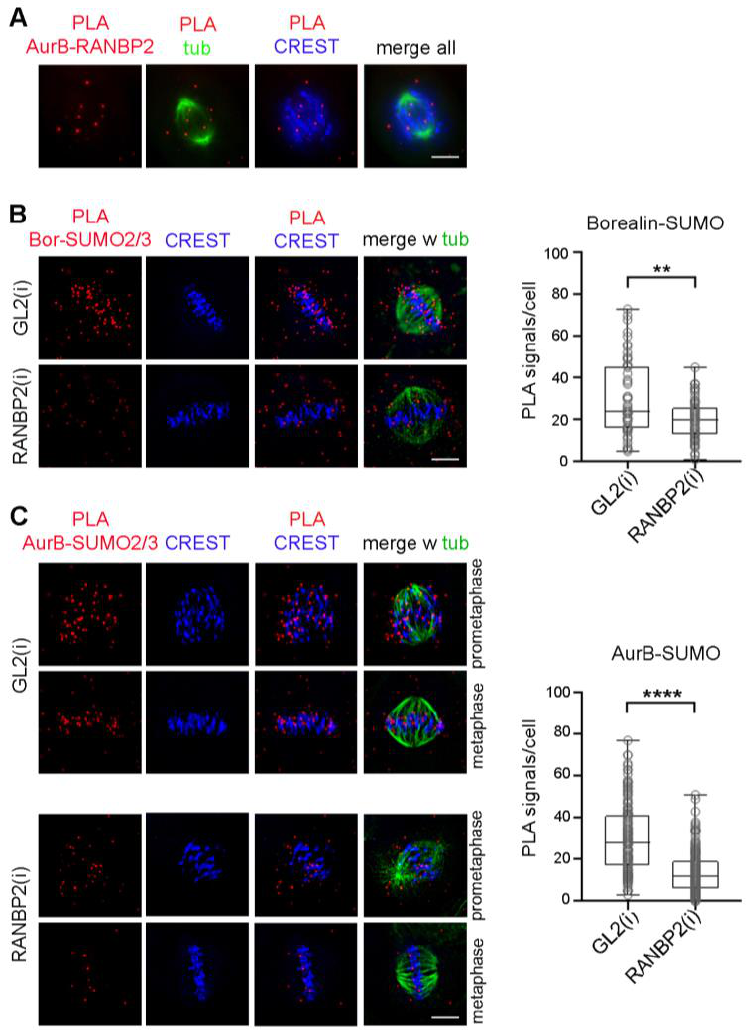
Figure 5. RANBP2 is required for Aurora B-SUMO2/3 PLA products. ( A ) RANBP2 and Aurora B form PLA products in mitotic cells. A representative late prometaphase is shown, in which PLA signals are juxtaposed to kinetochores (CREST, blue). ( B ) Borealin-SUMO2/3 PLA reactions in a control metaphase treated with neutral siRNAs (GL2) and, below, in a RANBP2-interfered cell. The box plot represents Borealin-SUMO2/3 PLA signals per cell in control (n, 55) and RANBP2-interfered (n, 65) metaphases in 2 experiments (**, p < 0.01). ( C ) Aurora B-SUMO2/3 PLA signals were analysed under the same conditions as above, in control (GL2) and RANBP2-interfered cells. Exemplifying prometaphases and metaphases are shown. The box plot represents Aurora B-SUMO2/3 PLA signals per cell in controls (n, 150) and RANBP2-interfered (n, 200) cells in 5 experiments; ****, highly significant difference ( p <0.0001).